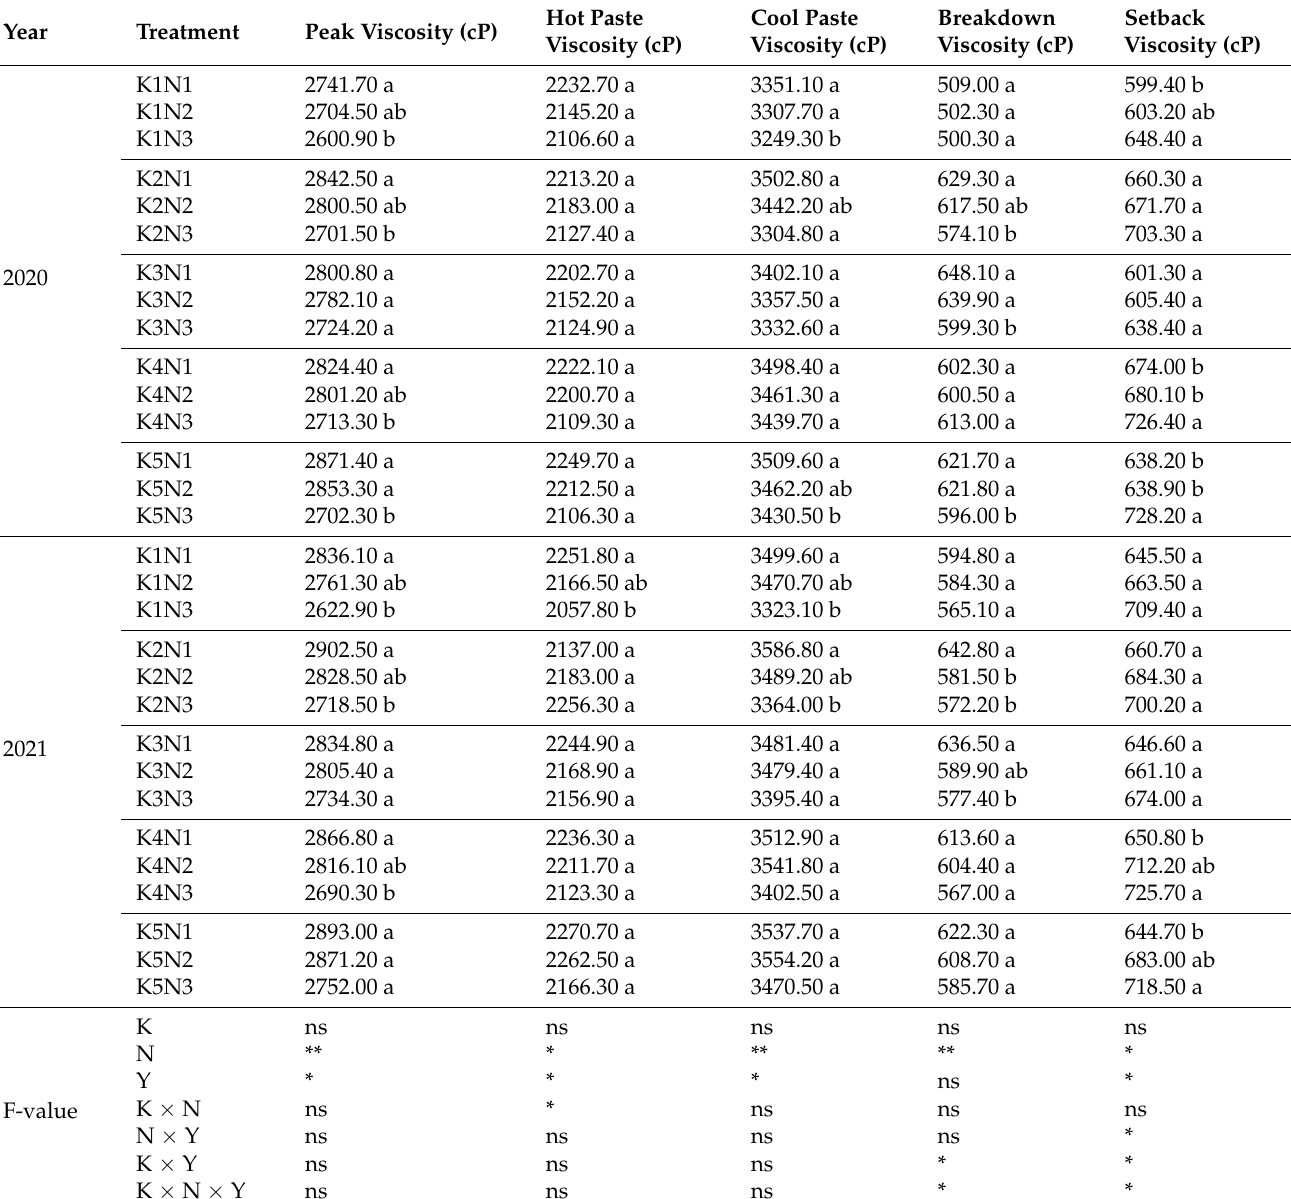
Table 5. Effects of different N and K combined application rates during the panicle stage on RVA profile characteristics in 2020 and 2021, with the results of the three-way